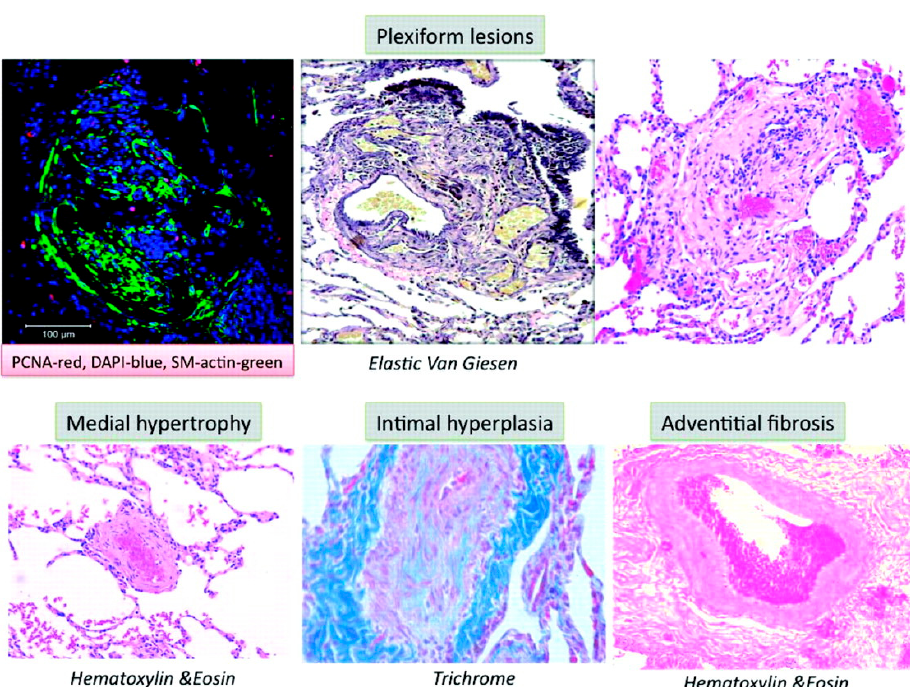
Figure 2. Pulmonary artery histology in pulmonary arterial hypertension (Reproduced with permission from Archer et al., 2010 [38]. Copyright 2010, Wolters Kluwer Health).